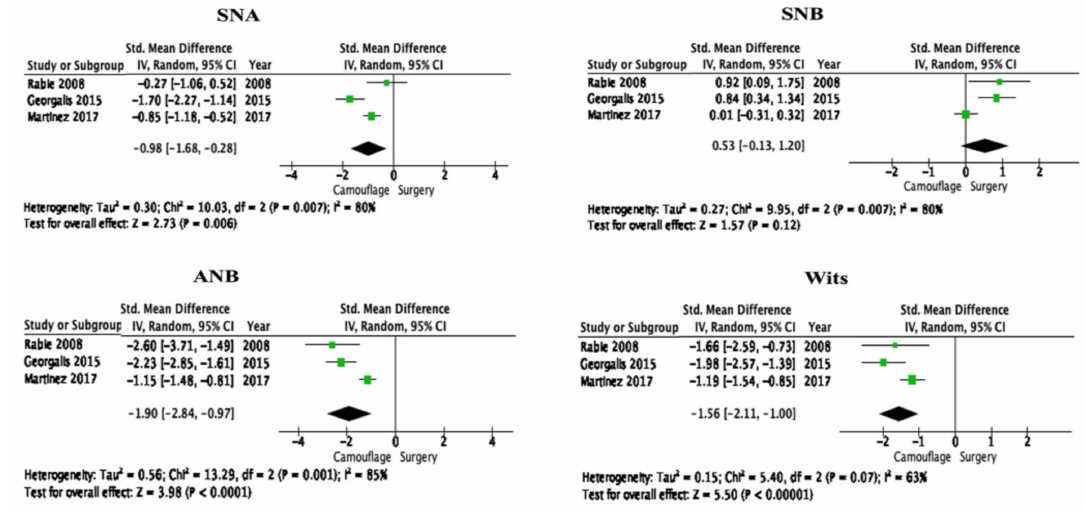
Figure 3. Forest plots for sagittal measurements.